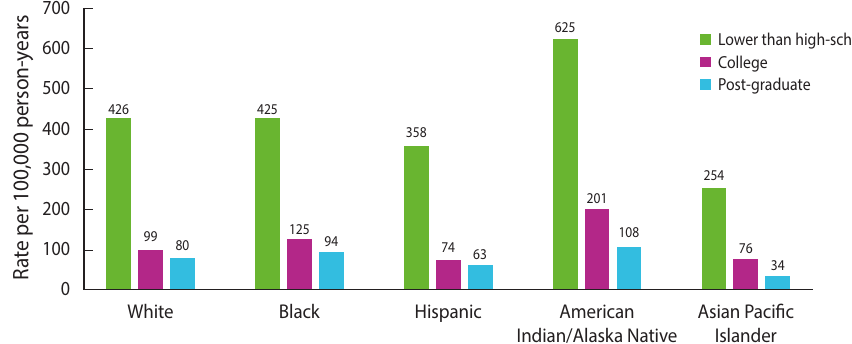
Figure 1. Coronavirus disease 2019 mortality rates by race/ethnicity and education in the United States